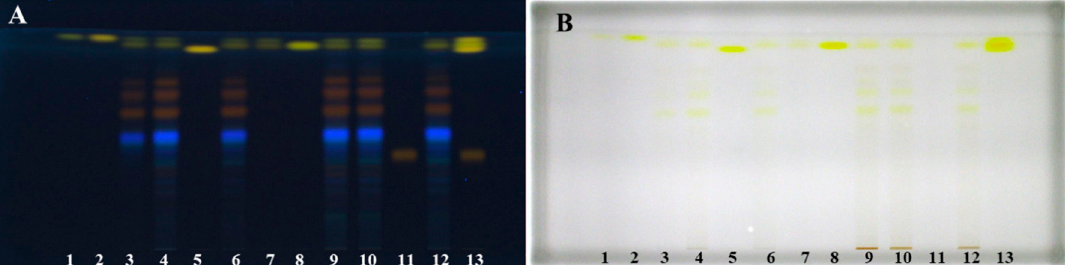
Figure 1. HPTLC chromatograms of physcion (1 μ g; track 1), chrysophanol (1 μ g; track 2), aloe-emodin (1 μ g; track 5), emodin (1 μ g; track 8) and aloin A (1 μ g; track 11) standards and